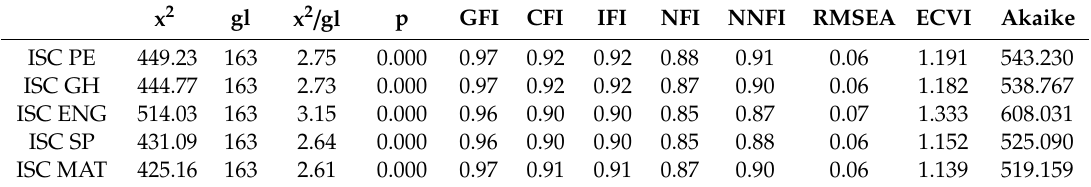
Table 5. Models fit